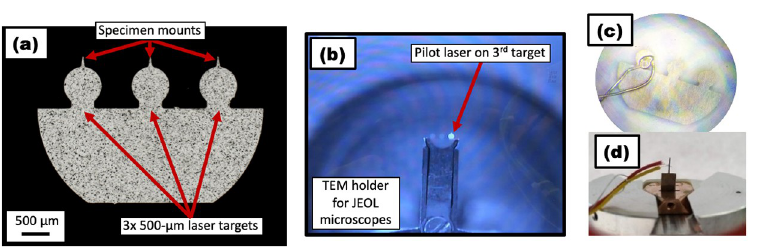
Fig 3. Sample mountings and thermocouple weldings (a) Schematic of the cold-rolled 304 stainless steel Reacthub grid with 500- μ m targets; (b) Laser focus on one grid; (c) Thermocouple spot welded to one of a Reacthub grid’s 500- μ m targets; (d) A thermocouple attached to the “candle” geometry, here made of a high strength dual phase steel by electrical discharge